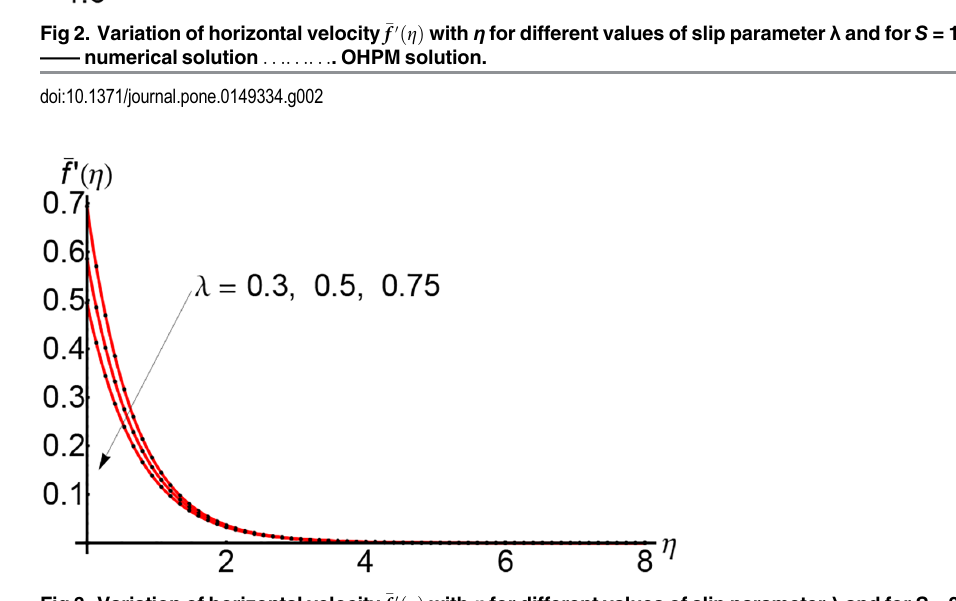
Fig 3. Variation of horizontal velocity (cid:2) f 0 ð Z Þ with η for different values of slip parameter λ and for S = 2: —— numerical solution ......... . OHPM solution.